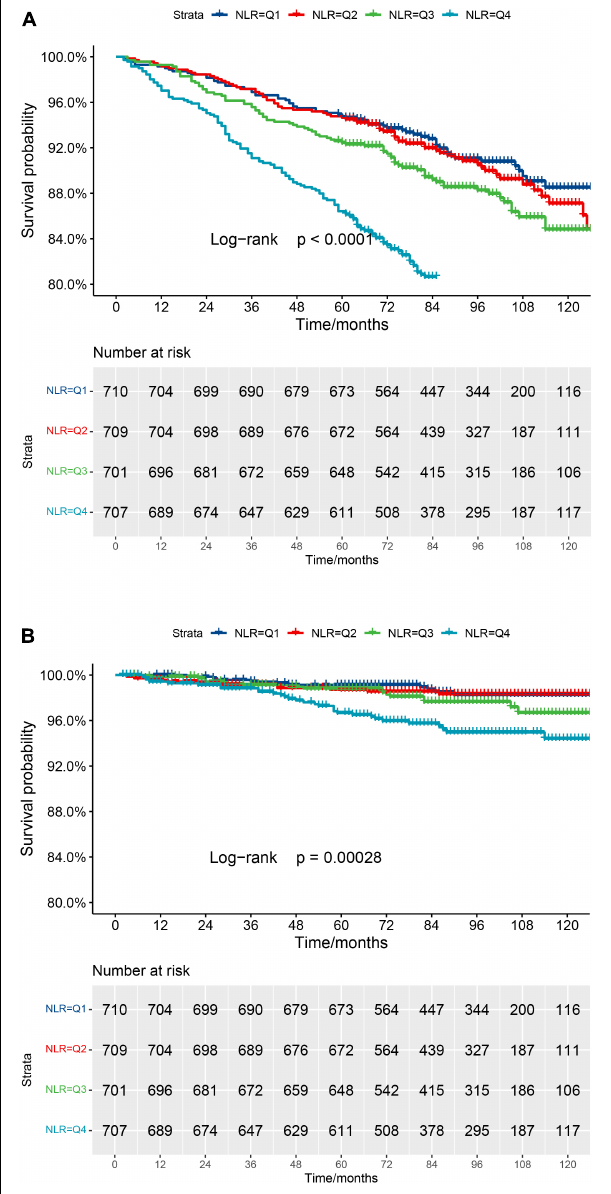
nomogram. For cardiovascular mortality ( Figure 3B ), variables of race, smoking, and plasma FBG level were replaced by hypertension, diabetes, and GHB level. Besides, we added the variable “cancer” to the nomogram. A 65-year old non-Hispanic Black man, with a history of tobacco use, complains of recent poor health. His laboratory test results are as followed: